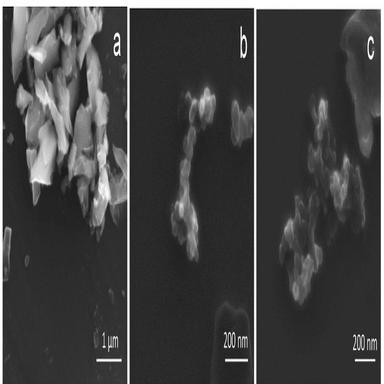
Size, shape, and behavior of dry urban air PM2.5 (A), urban PM2.5 after washing with physiologic serum and SDS solution (B), isolated PMs from ECM (C).